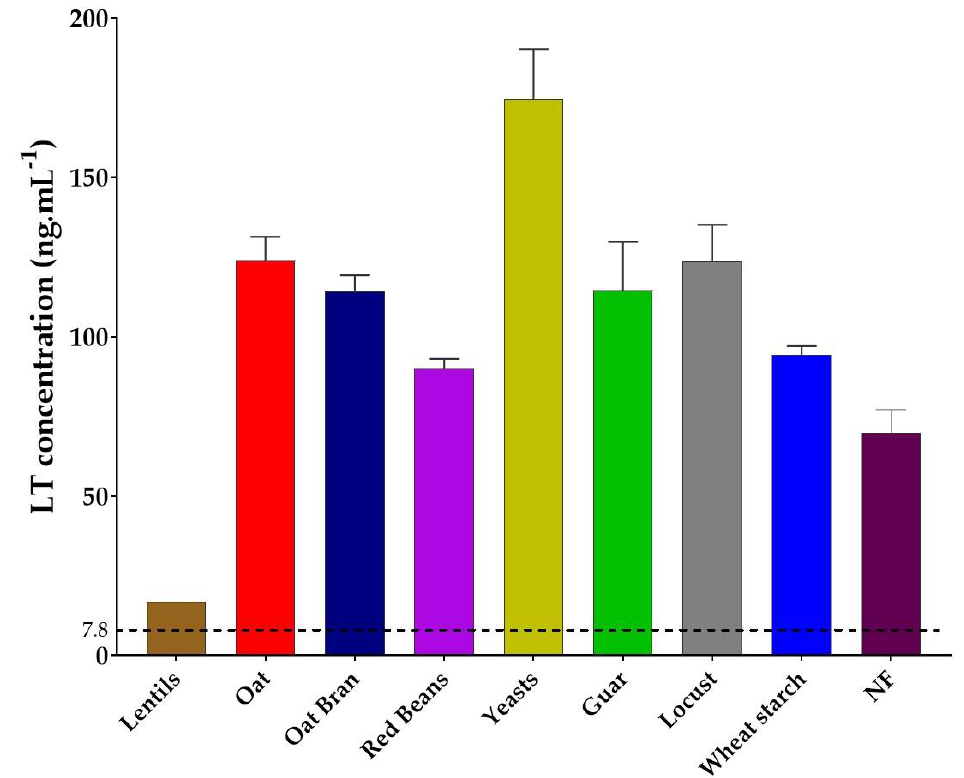
Figure 2. Effect of fiber-containing products on LT toxin concentration after an overnight culture of ETEC strain H10407 in CAYE medium. Fiber-containing products were tested at 2 g·L − 1 of final fiber content. Results are expressed as mean ng·mL −1 of toxin (±SD) of three independent biological replicates. For lentil extracts, only one biological replicate is repre- sented as toxin was not detected in the two other replicates. No statistical test was performed because of these two under- threshold results. The detection threshold (7.8 ng·mL −1 ) is indicated by a dotted black line. NF = control condition with no product added, SD = standard